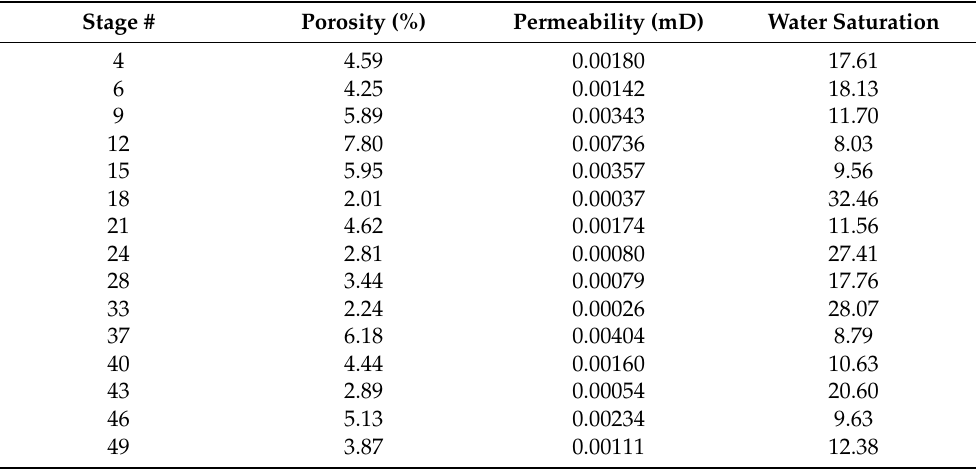
Table 5. Reservoir properties for 15 selected stages. Permeability and water saturations were calculated using the equations of Wood [47], which are based on empirical relationships derived from core and log data from the Montney Formation.